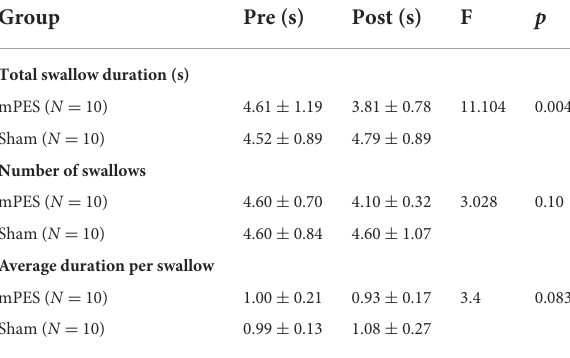
TABLE 2 Behavioral results of the 150 ml-water swallowing stress test.